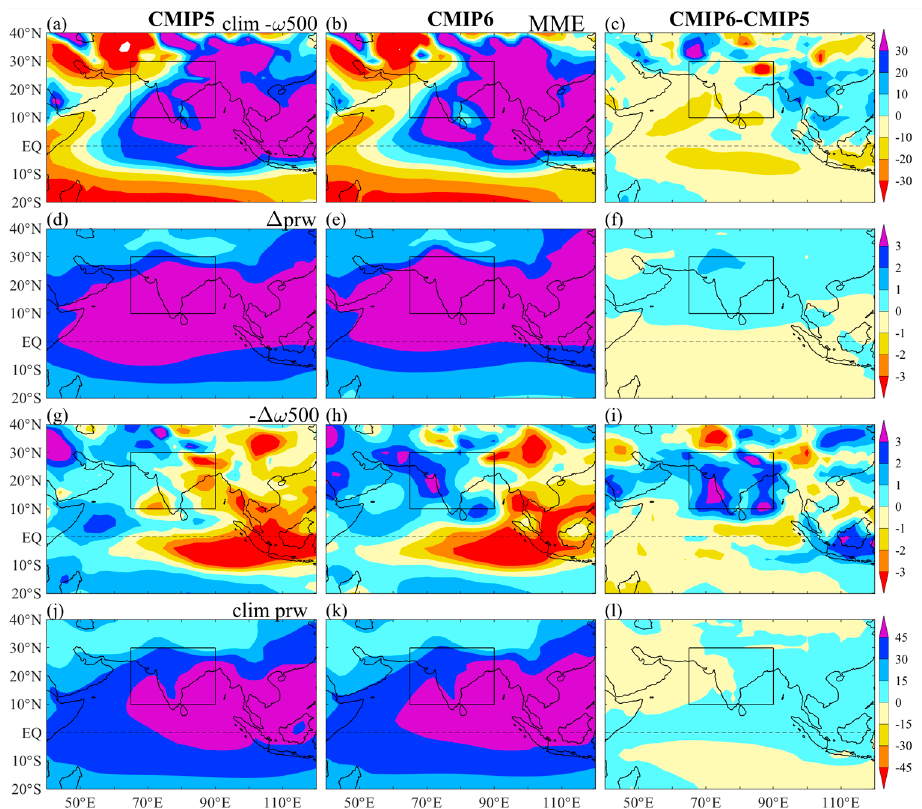
Figure 4. June–July–August–September (JJAS) mean ( a–c ) climatological vertical velocity at 500 hPa (clim − ω 500 , positively upward, hPa day − 1 ), ( d–f ) water vapor change ( ∆ prw , g kg − 1 ), ( g–i ) vertical velocity change at 500 hPa ( − ∆ ω 500 , hPa day − 1 ) and ( j–l ) climatological water vapor ( prw , g kg − 1 ) under RCP2.6 in CMIP5 and SSP1-2.6 in CMIP6 and their differences.